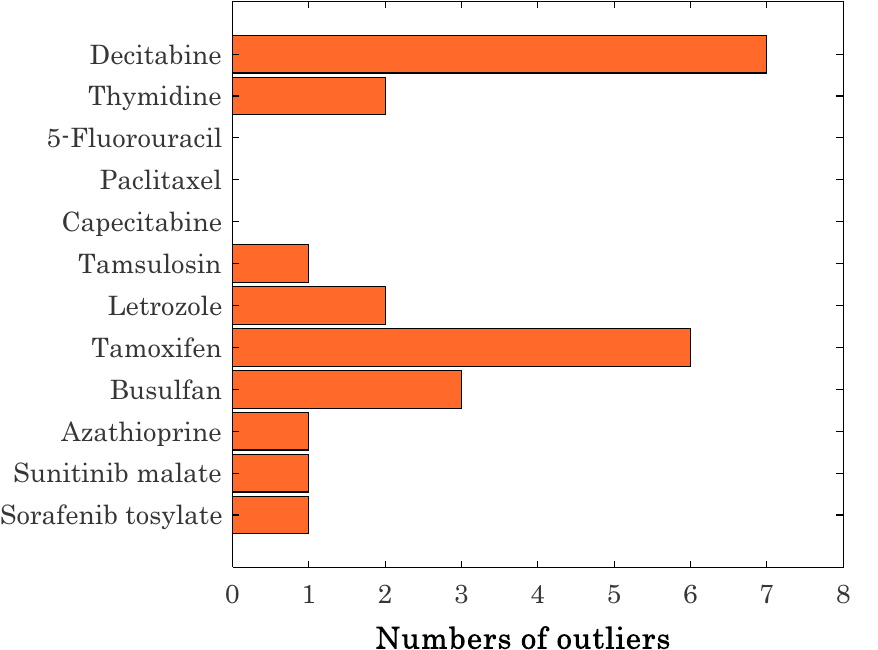
Figure 10. Numbers of detected outliers for the considered anti-cancer drugs.